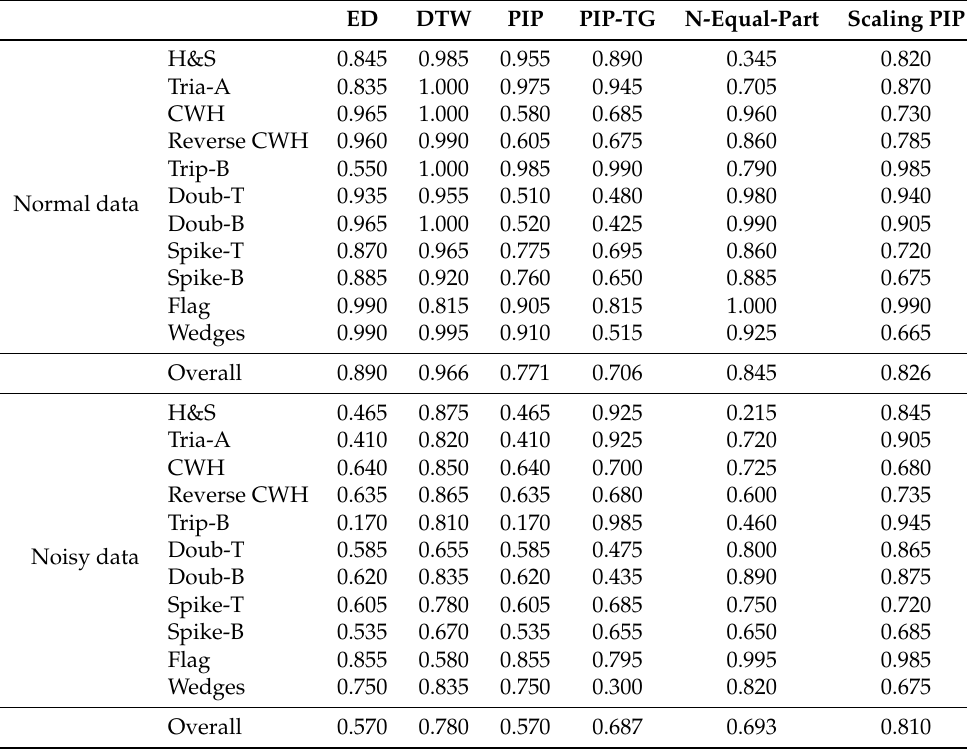
Table 4. The overall accuracy of each model on the synthetic